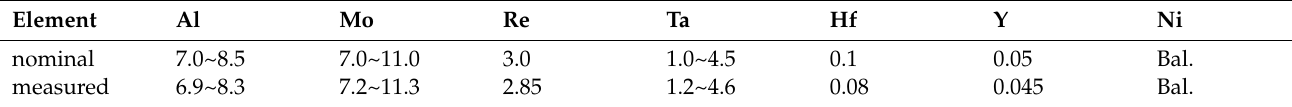
Table 1. Chemical composition of the experimental superalloy, wt.%.